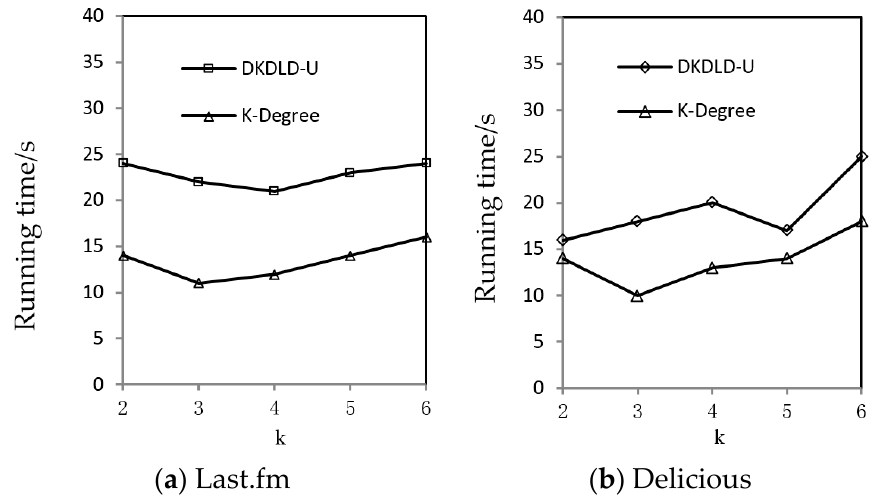
Figure 4. Last.fm dataset ( a ) and Delicious dataset ( b ): running time for different k values.